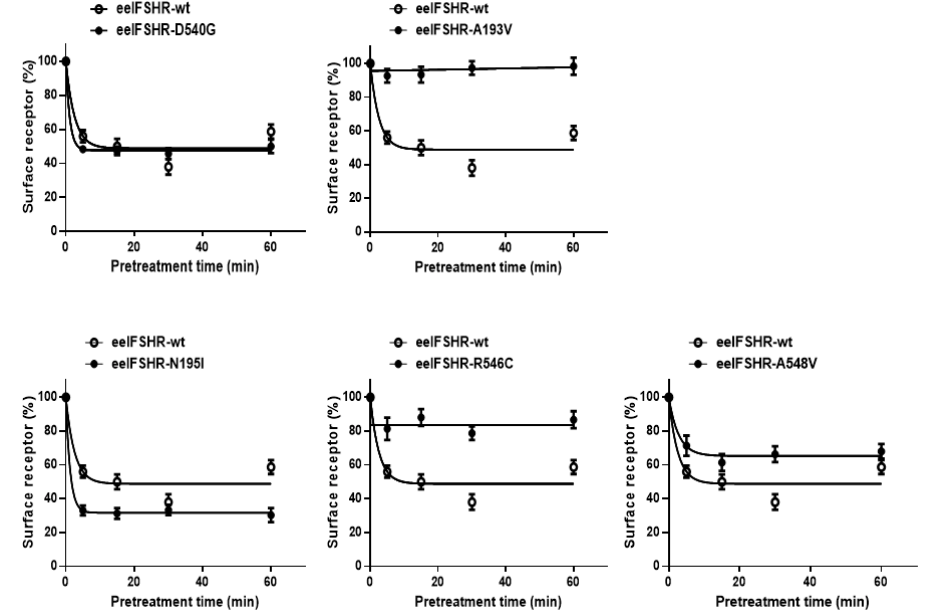
Figure 7. Time -dependent cell surface loss in the wild-type eelFSHR and in the activating / inactivating eelFSHR mutants. HEK-293 cells transiently expressing wild-type eelFSHR or activating / inactivating receptor were incubated with 1000 ng / mL recombinant eelFSH (rec-eelFSH) for up to 60 min. Cell surface expression in the non-pretreated groups was taken as 100% (see Materials and Methods for details). The loss of each receptor was shown using GraphPad Prism software. The results are expressed as the means ± SE of three independent experiments. In this figure, mean data were fitted to the one phase exponential decay equation. The blank circles were the same curves of wild-type